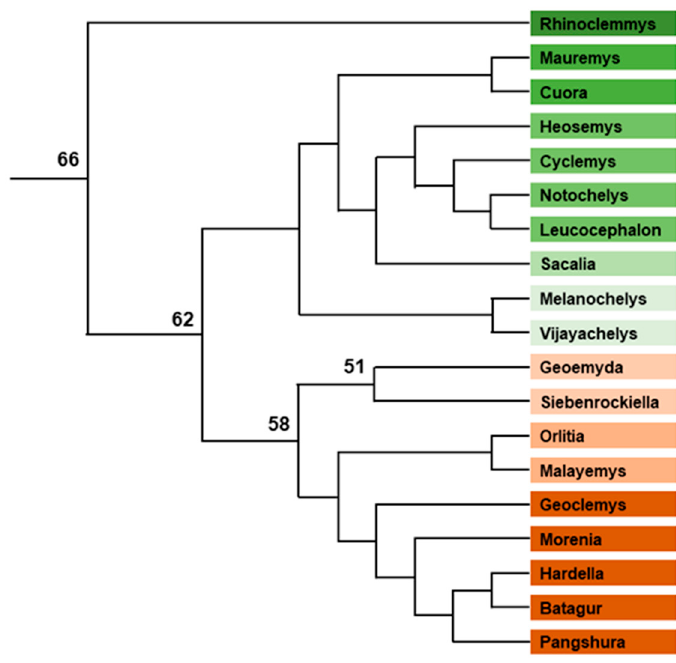
Figure 6. Phylogenic tree of geoemydid turtles. Relative position of each genus and superior clade are represented. Branch lengths are not proportional to time. Numbers indicate divergence time (Myrs) from the present for some key nodes, according to [39]. Color of each genus indicates the different clades.